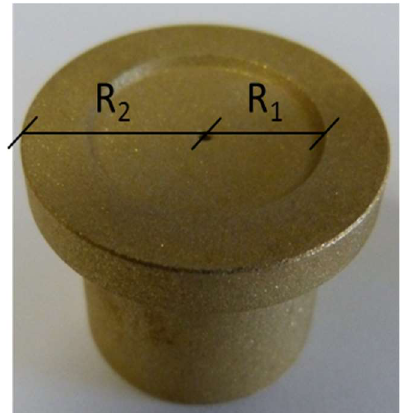
Figure 2. Sandblasted brass slippers. Inner radius R 1 and outer radius R 2 are reported.